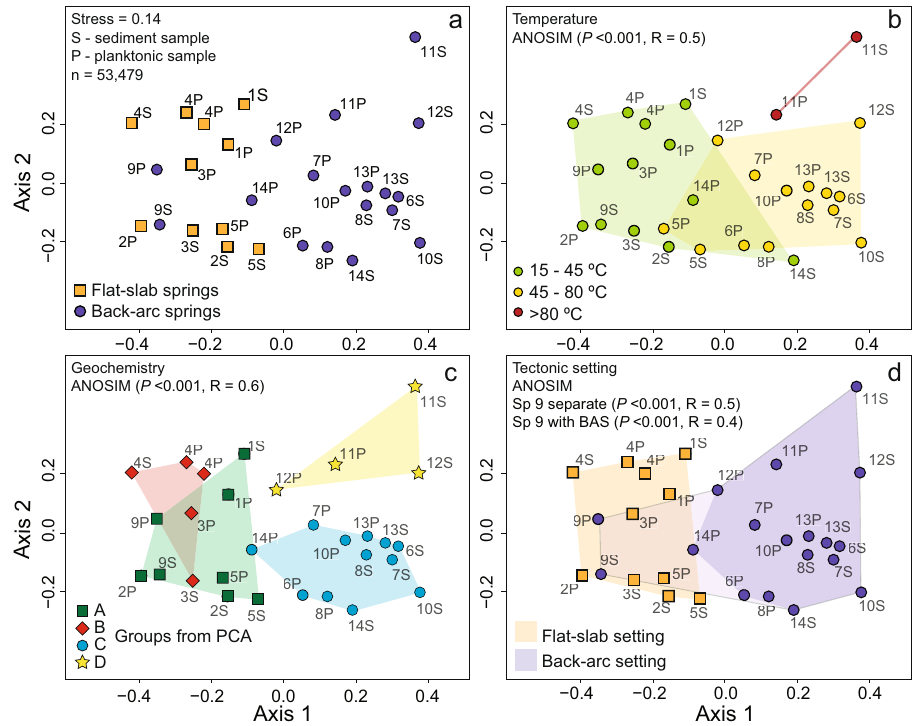
Fig. 4 Multivariate statistical analyses of hot spring 16S rRNA gene data. a Non-metric multidimensional scaling ordination based on Bray – Curtis dissimilarity for all 16S rRNA gene operational taxonomic units (OTUs, n = 53,479) in the 14 springs, with the planktonic and sediment community samples designated. Also the color coding links to the geographic location of the springs shown in Fig. 1. b – d Analysis of Similarities (ANOSIM) results for treatments overlain on this ordination based on b spring temperature range, d geochemistry (principal component analysis groups), and d tectonic settings. Note that Sp. 9 is an outlier to other BAS, and clusters with FSS on the ordination. The tectonic setting ANOSIM shown in d treats Sp. 9 separately as its own group ( P < 0.001, R = 0.5), and as included with the back-arc ( P < 0.001, R = 0.4).